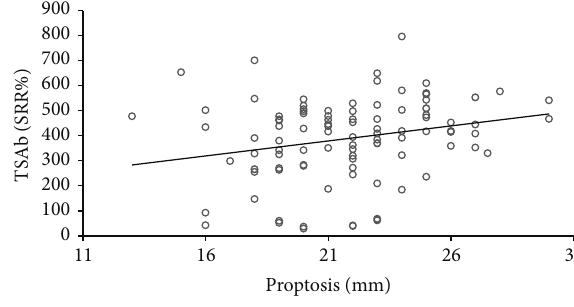
Figure 3: Correlation of serum TSAb levels with proptosis. Spear- man’s rho = 0.27; 𝑃 = 0.007 .